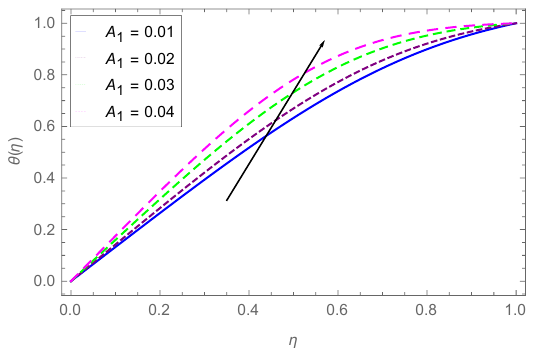
Figure 18. Graph depicting θ ( η ) dependence on A 1 . The dependence of the Nusselt number ( Nu ) on δ for changing values of Pr is plotted in Figure 19. The figure shows that for a fixed value of Pr , Nu does not change with the variation in the values of δ . Furthermore, the plot also shows that by increasing Pr to larger values, Nu also increases in approximately equal proportions. Thus, the increasing Pr, which is due to the higher values of momentum diffusivity, augment the convective thermal energy flow of the